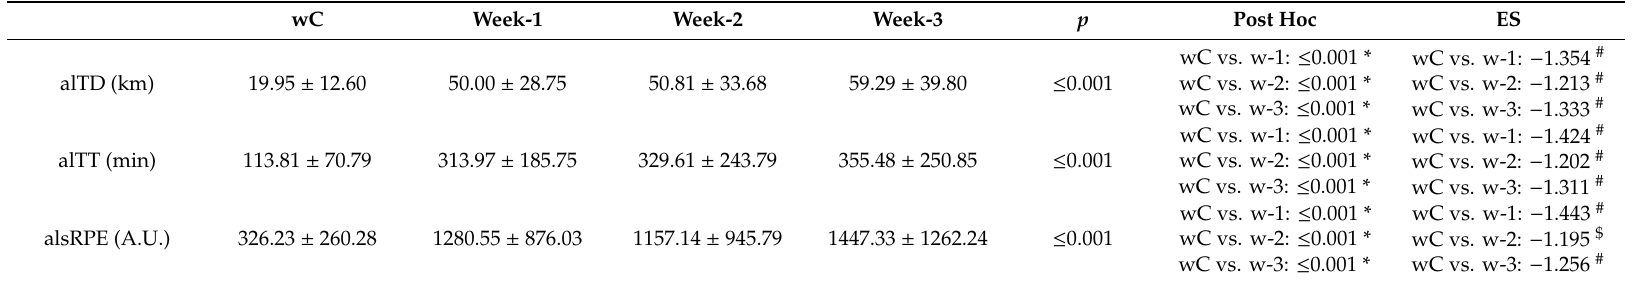
Table 5. Descriptive statistics of workload measures before ultra-trail long / extra-long (UT-L / XL)